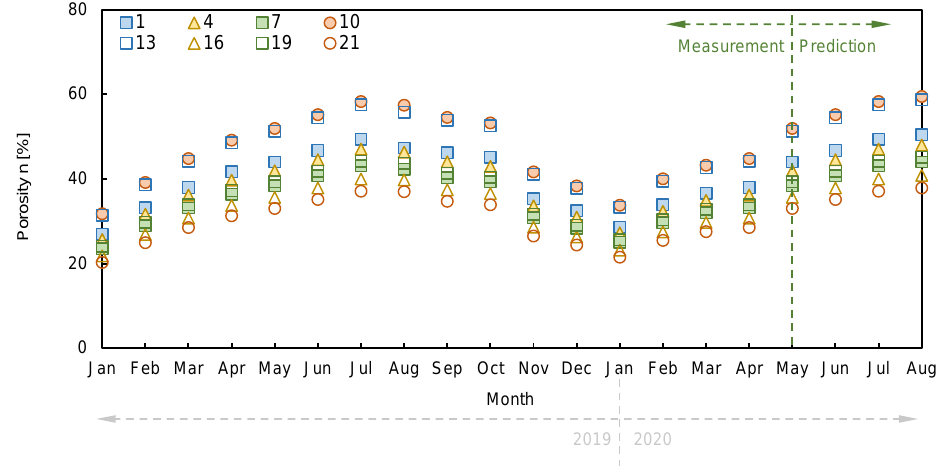
Figure 11. Distribution of porosity according to a time series.